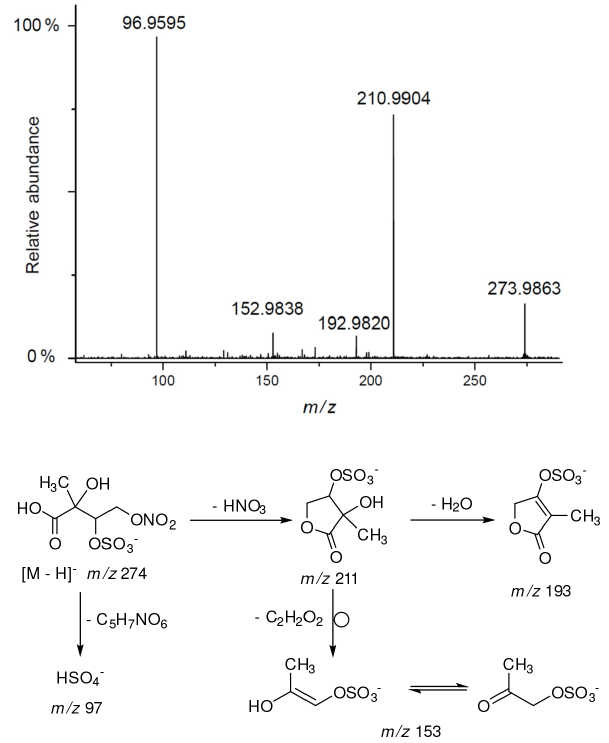
Figure 15. Electrospray product ion mass spectrum ( − ) of 2-methylthreonic acid nitroxy-organosulfate (MW 275) of the RT = 0.83min peak (Fig. S4) recorded for Zielonka PM 2 . 5 aerosol along with the proposed fragmentation